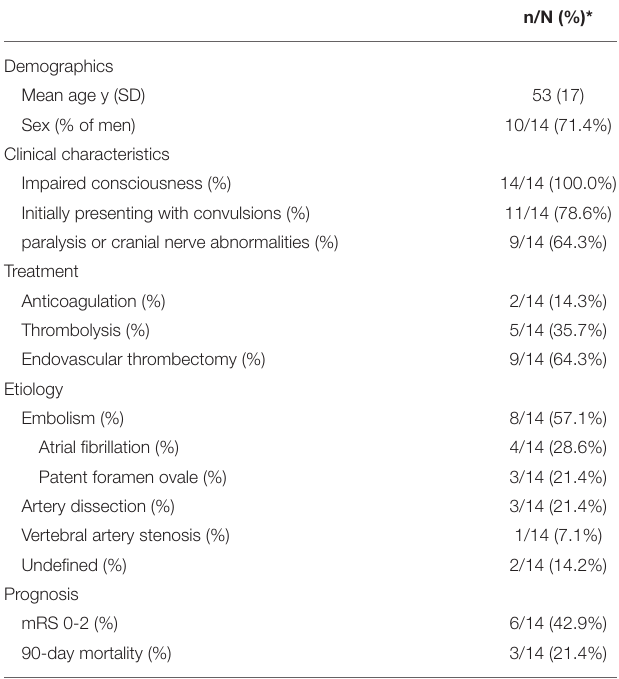
TABLE 2 | Clinical characteristics of acute basilar artery occlusion presenting with